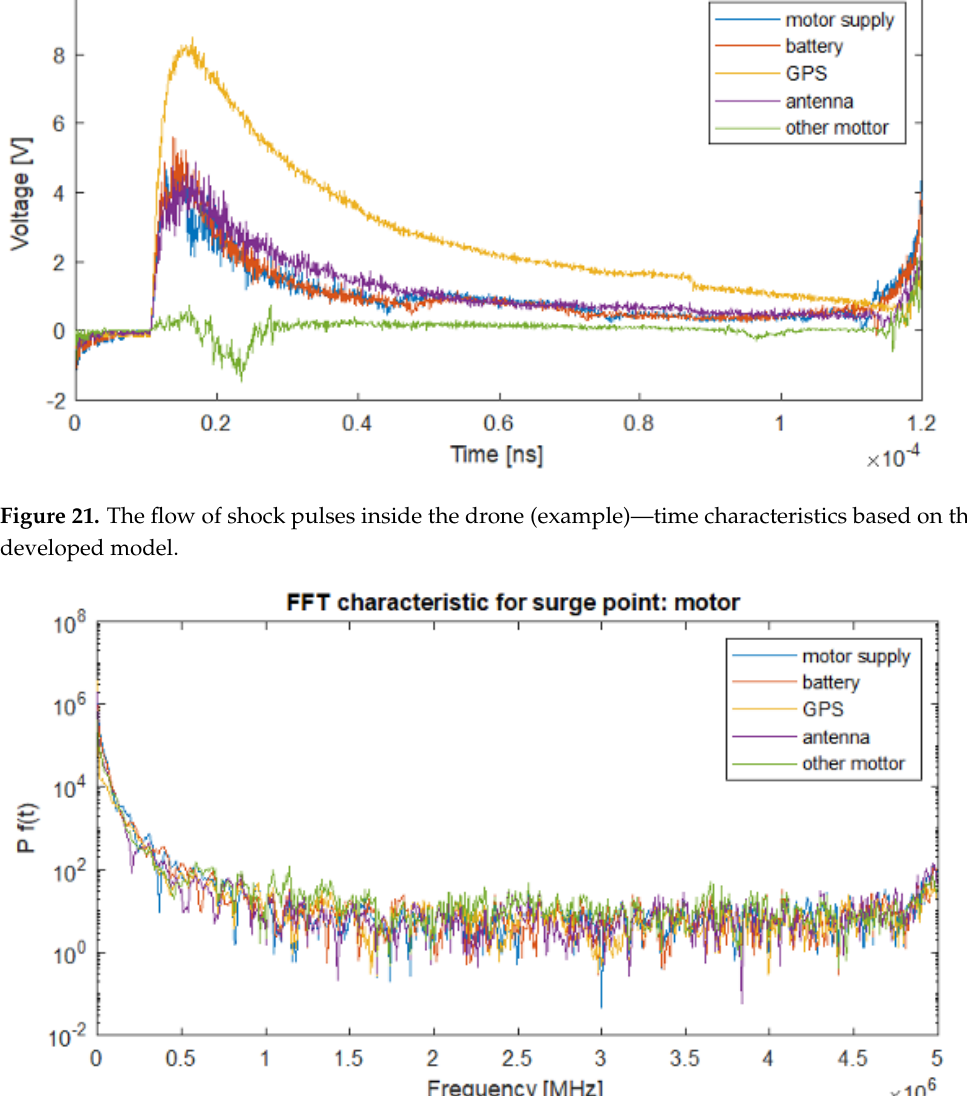
Figure 22. The flow of shock pulses inside the drone (example)—frequency characteristics based on the developed model.